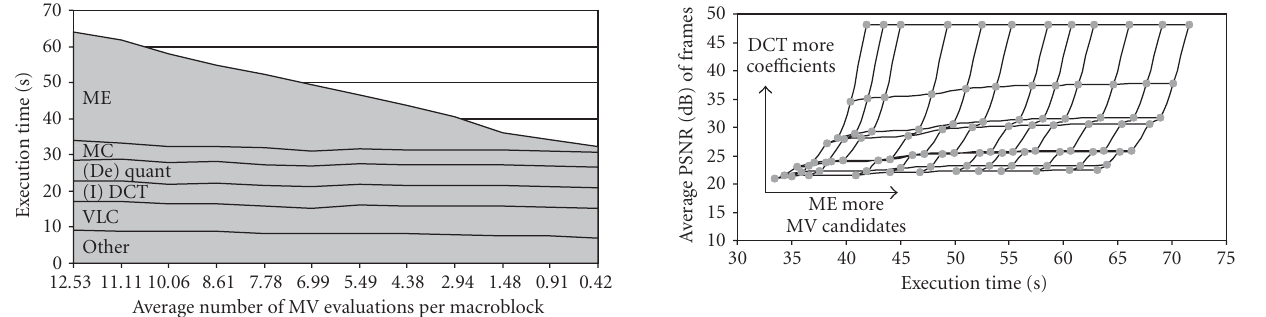
Figure 21: PSNR results of di ff erent configurations for the scalable MPEG modules.